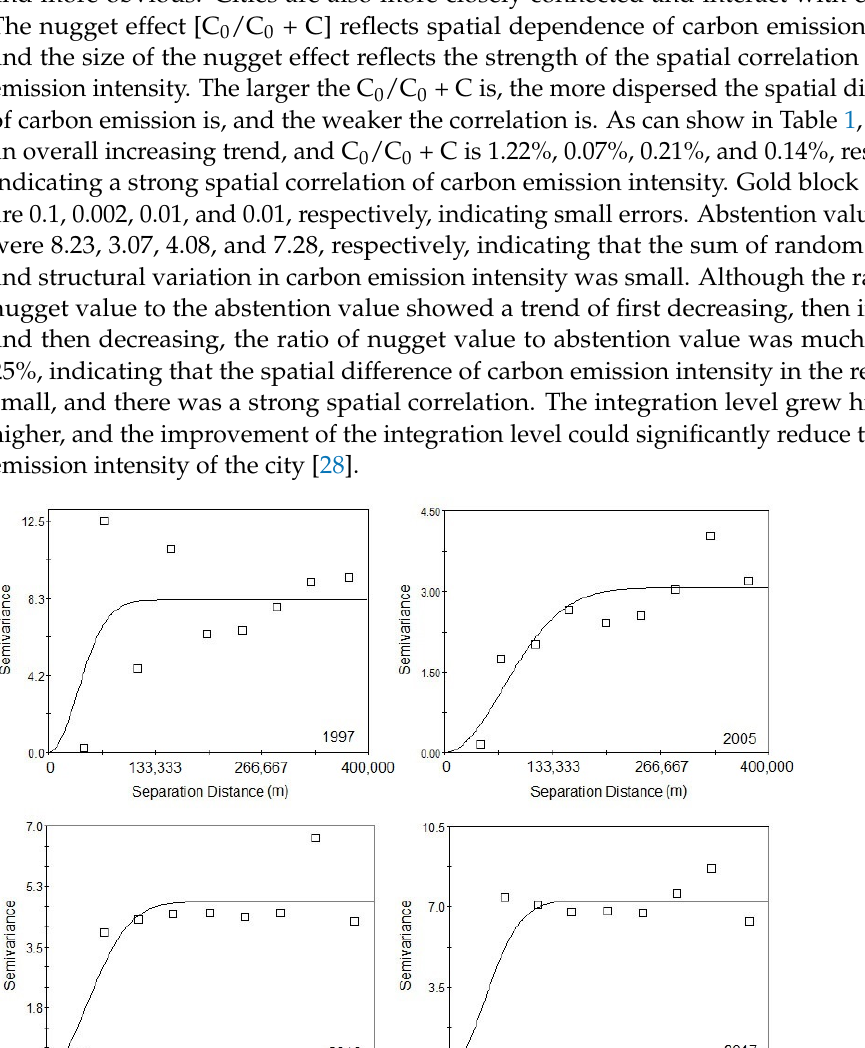
Figure 4. Geolocation of sample area. Hefei (HF), Wuhu (WH), Chzhou (CZ), Benbu